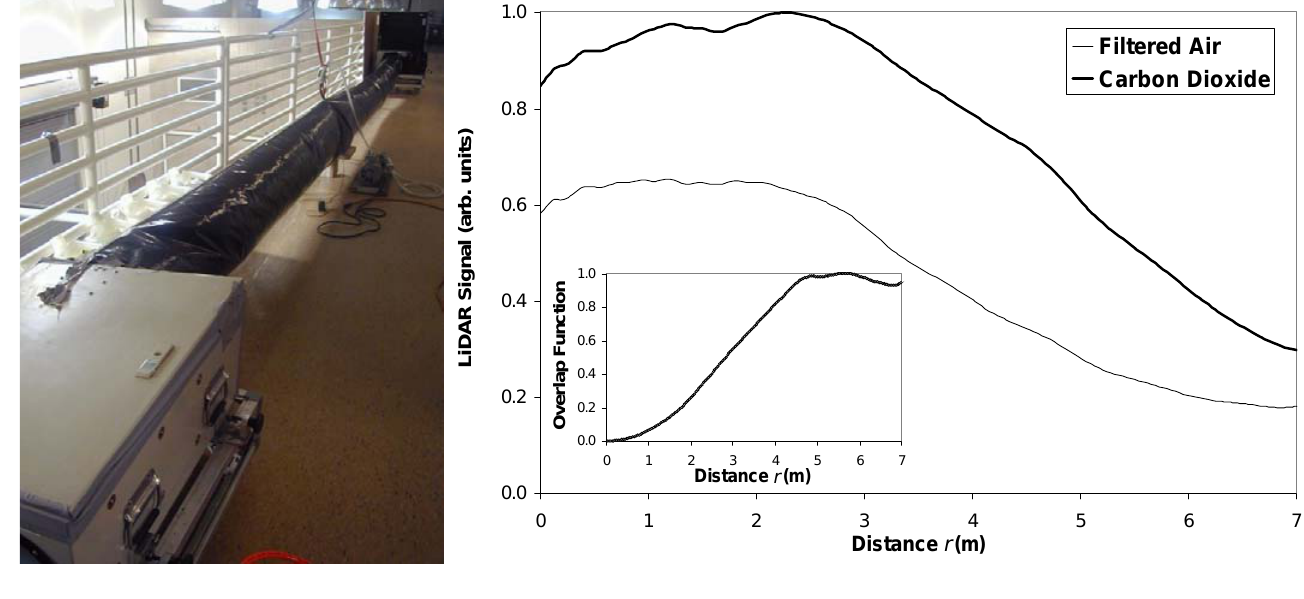
Figure 3. Picture of the calibration procedure and examples of data of the resulting LiDAR returns for filtered air and CO . The insert reports the calculated overlap 2